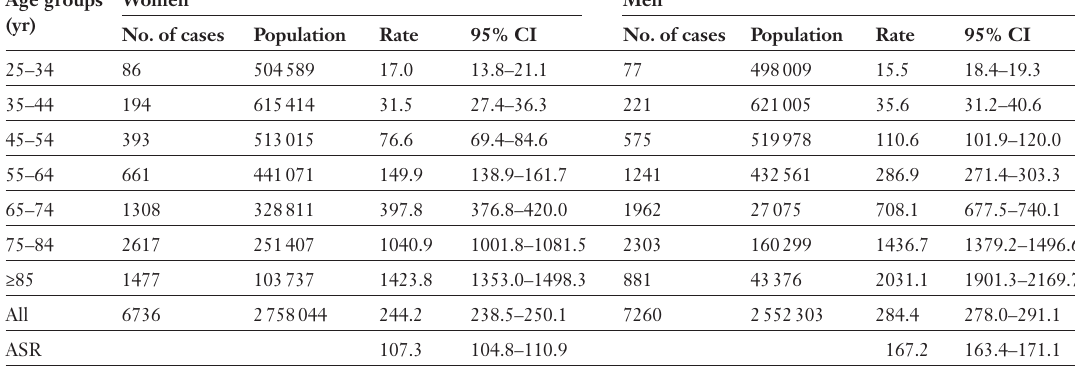
Table 1a Age-specific and age- standardised stroke discharges (absolute number of cases, and rate per 100000 pop- ulation) (Switzerland